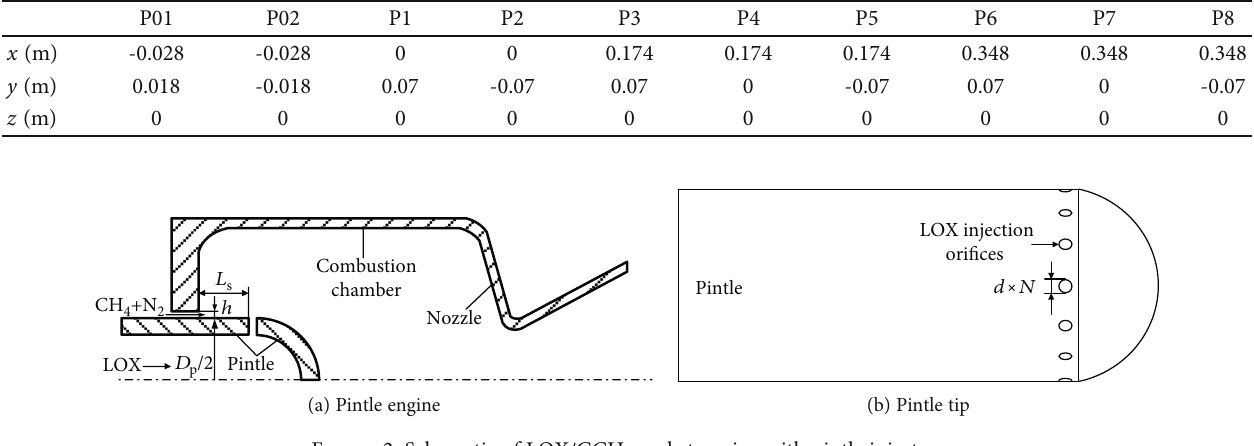
rocket engine with pintle injector. 4